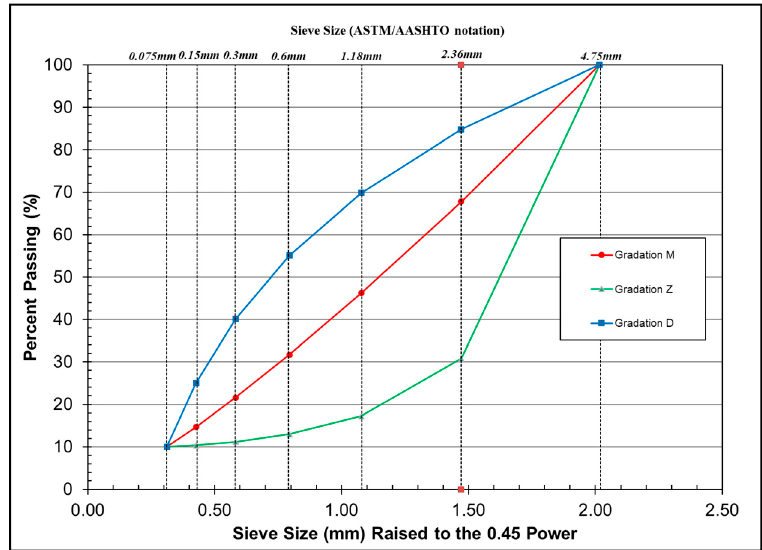
Figure 2. Gradation of AC-5 mixtures.